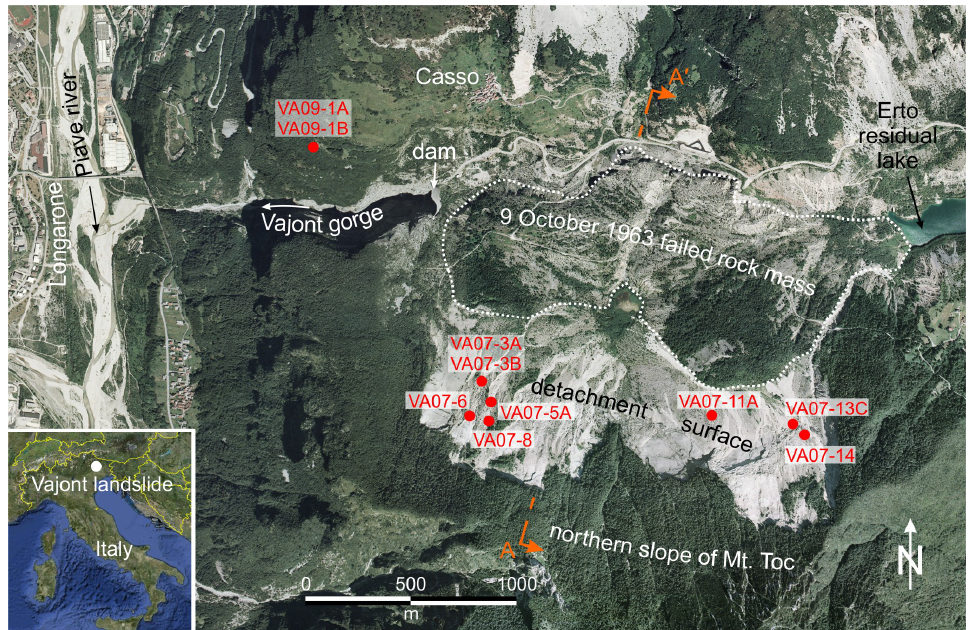
Figure 1. Orthophoto of the final stretch of the Vajont valley showing the detachment surface and the failed rock mass of the 1963 Vajont landslide. The location of the clay samples analyzed in the present study and the trace of the geological cross-section are also shown.